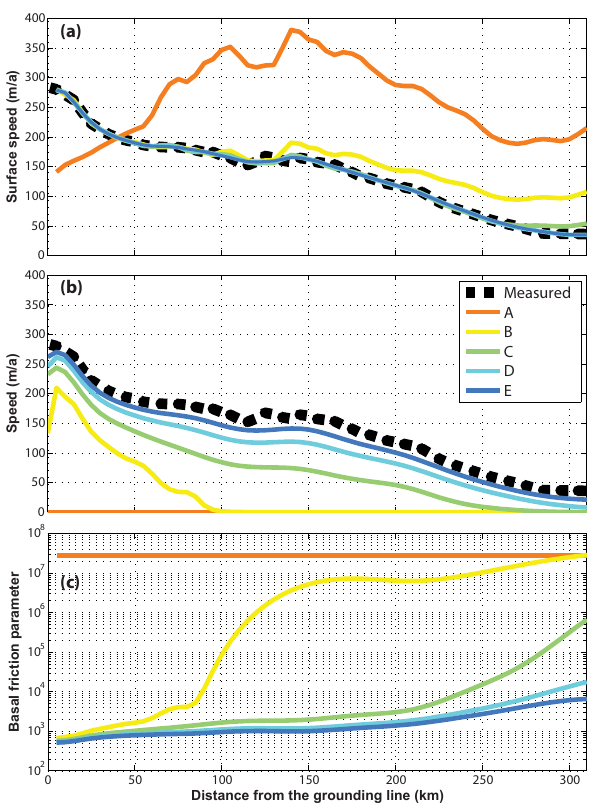
Fig. 5. (A) Observed surface flow speed (dashed black line) and optimized surface flow speed profiles along the central flowline of West Ragnhild Glacier; (B) Basal ice flow speed according to the optimization and compared to the satellite-observed surface flow speed (as in panel A ); (C) Basal friction β 2 along the